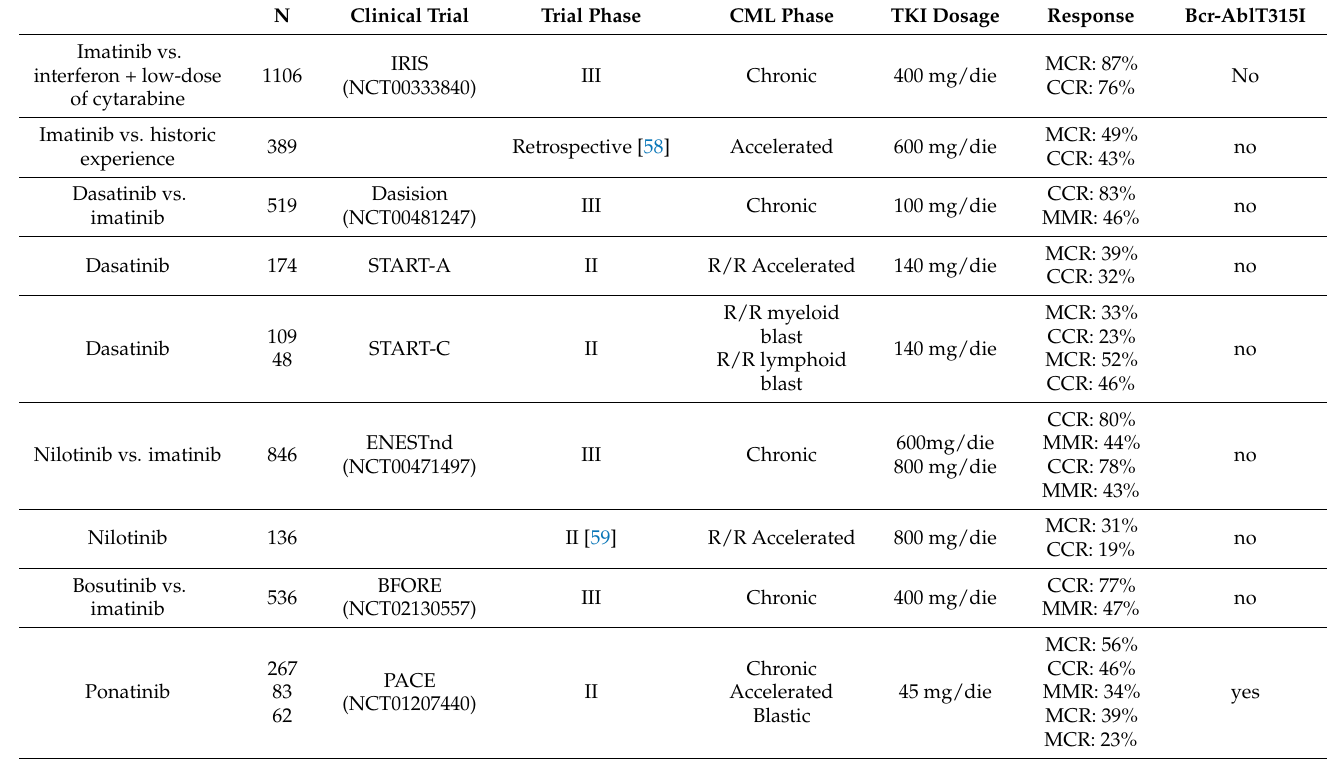
Table 2. Characteristics of first line BCR-ABL